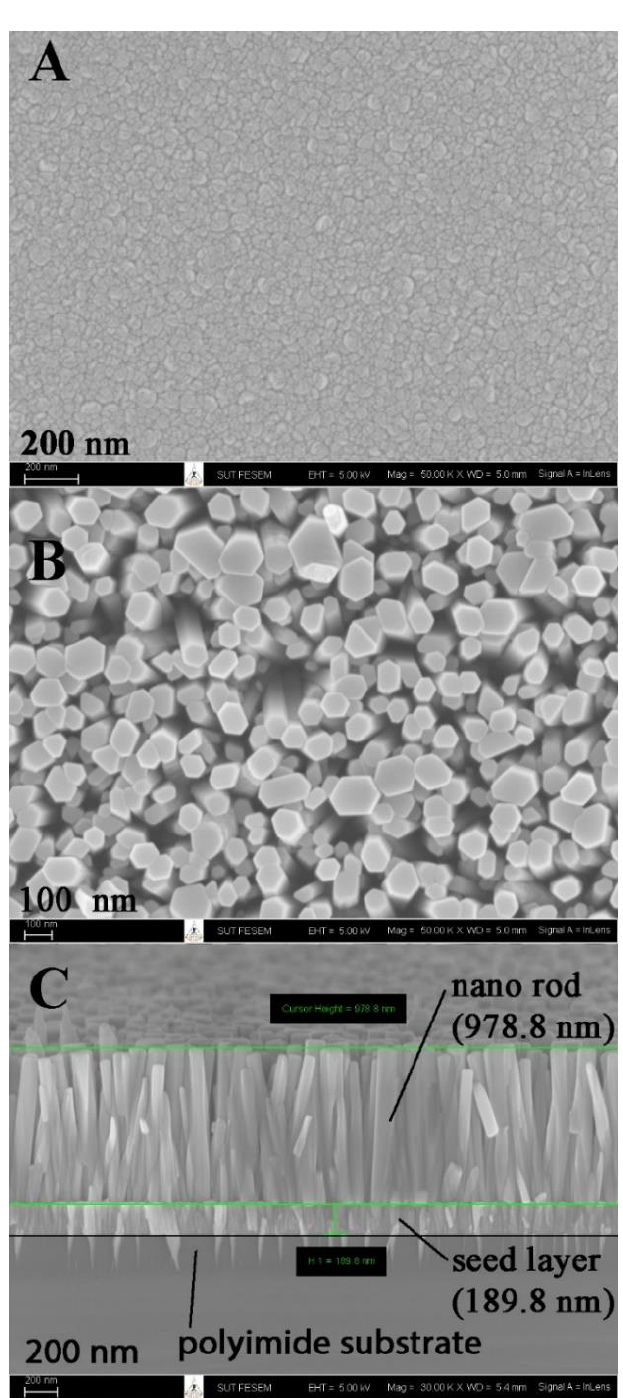
Figure 2. Scanning electron microscopy (SEM) micrographs of the ZnO seed layer prepared by sputtering ( A ) cross-section, ( B ) top view, and ( C ) after growth by the hydrothermal method.